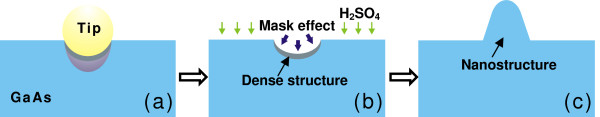
Schematic picture showing fabrication mechanism of GaAs nanostructure.